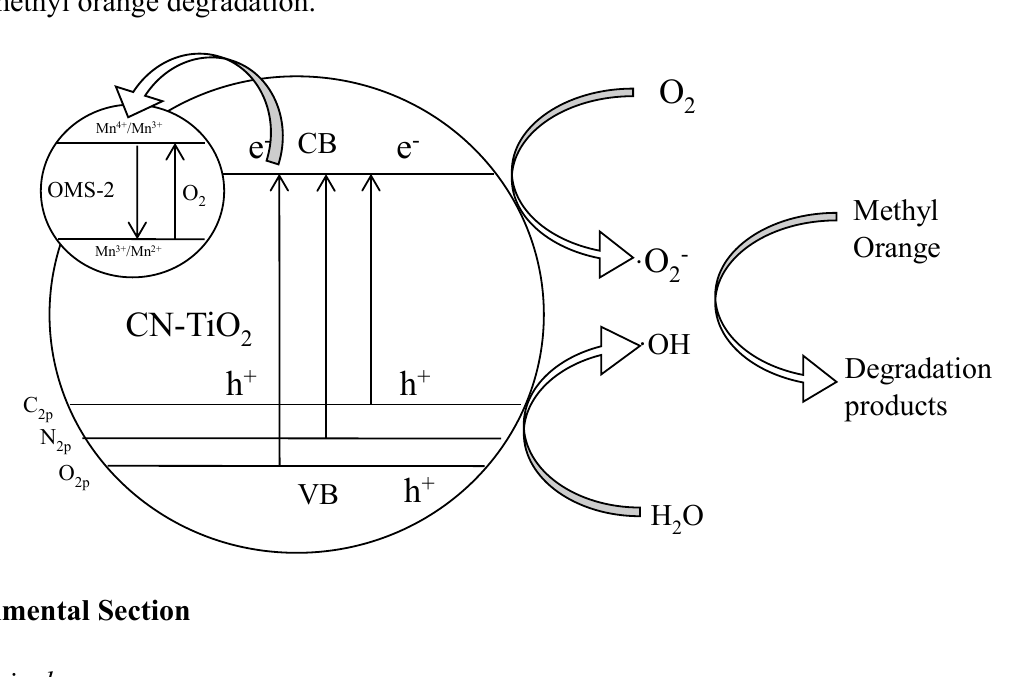
Figure 6. Possible mechanism for the photocatalytic activity of CN-TiO 2 /OMS-2 samples to methyl orange